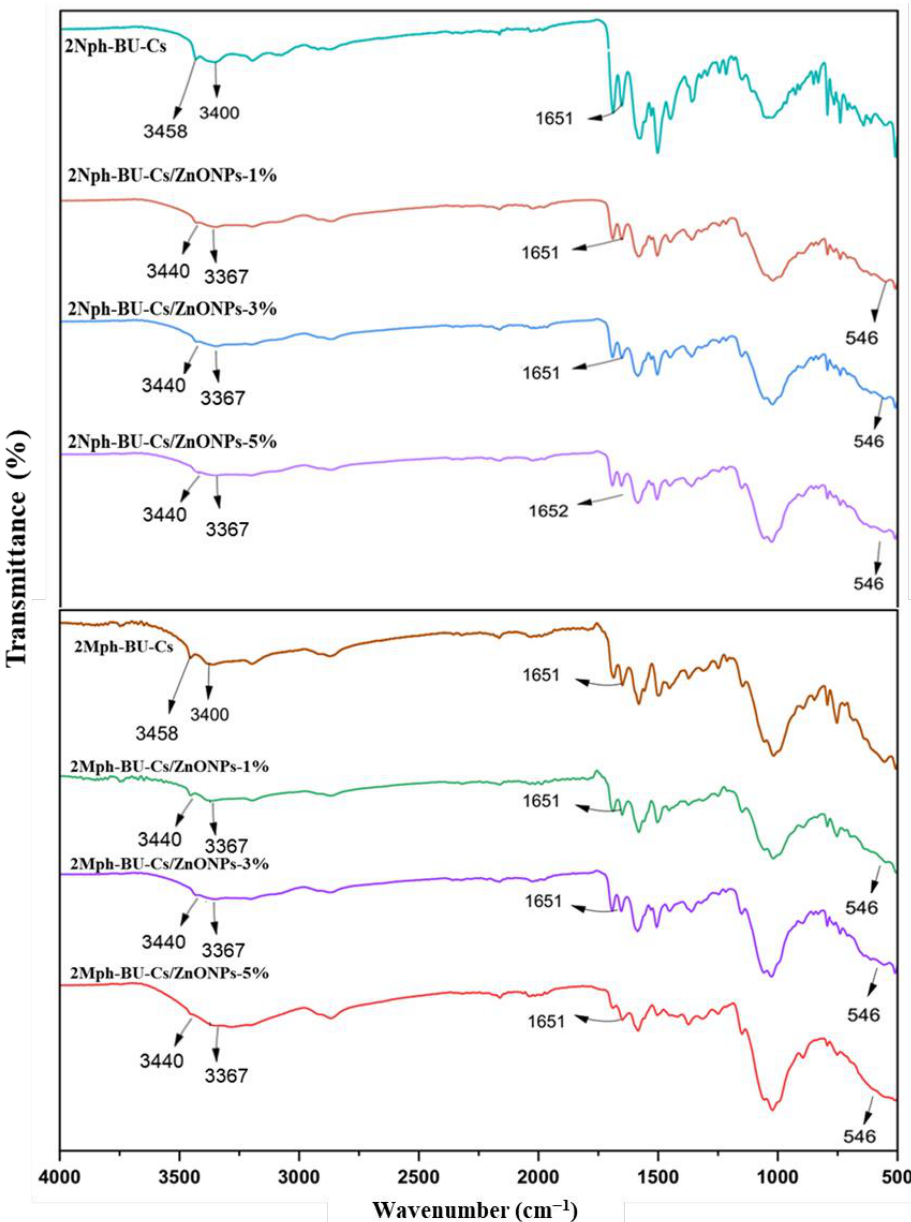
Figure 3. FTIR spectra of 2Nph-BU-Cs, 2Mph-BU-Cs, and their ZnO nanocomposites.